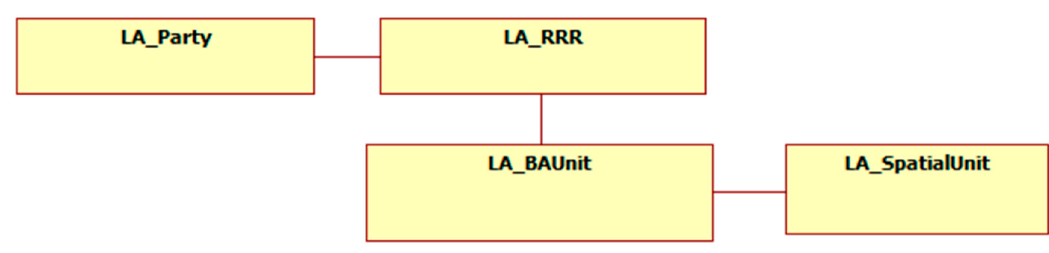
Figure 4. Basic classes of ISO 19152:12 Land Administration Domain Model (LADM) [27].